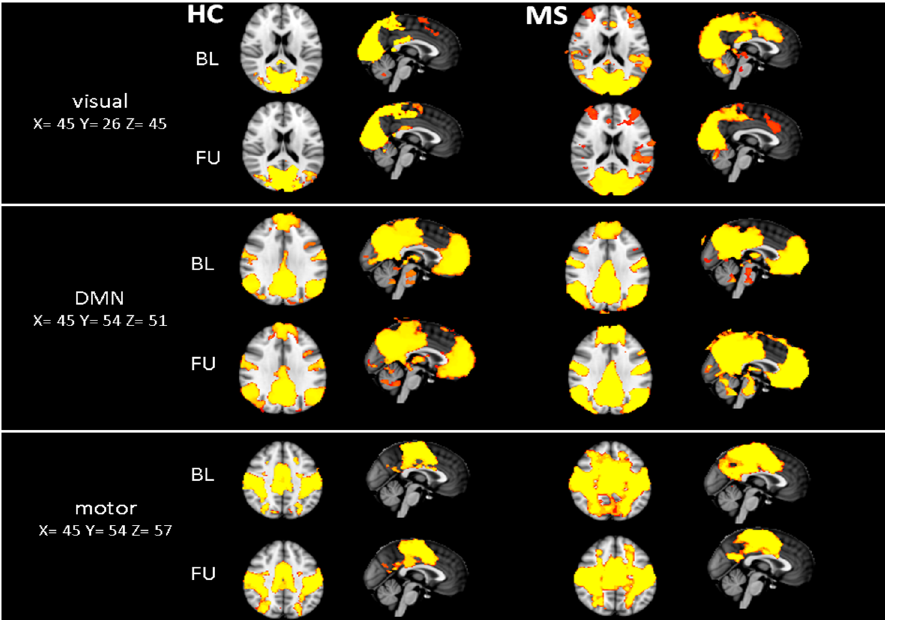
Fig 1. Group functional connectivity maps. Fig 1 illustrates the visual network (visual 00), the default- mode network (DMN) and sensorimotor network (motor) at baseline (BL) and follow-up (FU) for both groups. Tfce corrected p-values > 0.99. HC = Healthy controls, MS = patients with